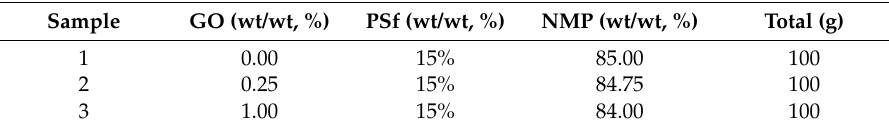
Table 1. Composition of prepared